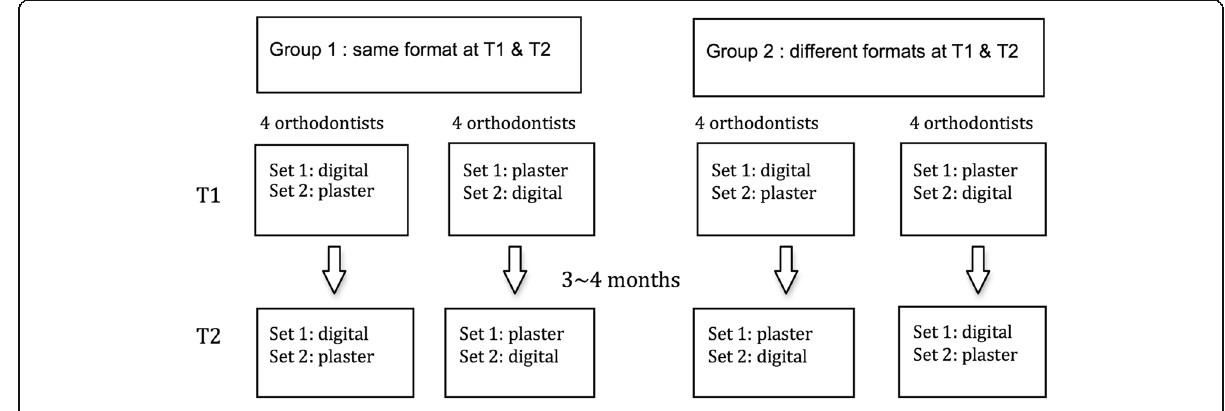
Fig. 1 Scheme for assignment of orthodontists and